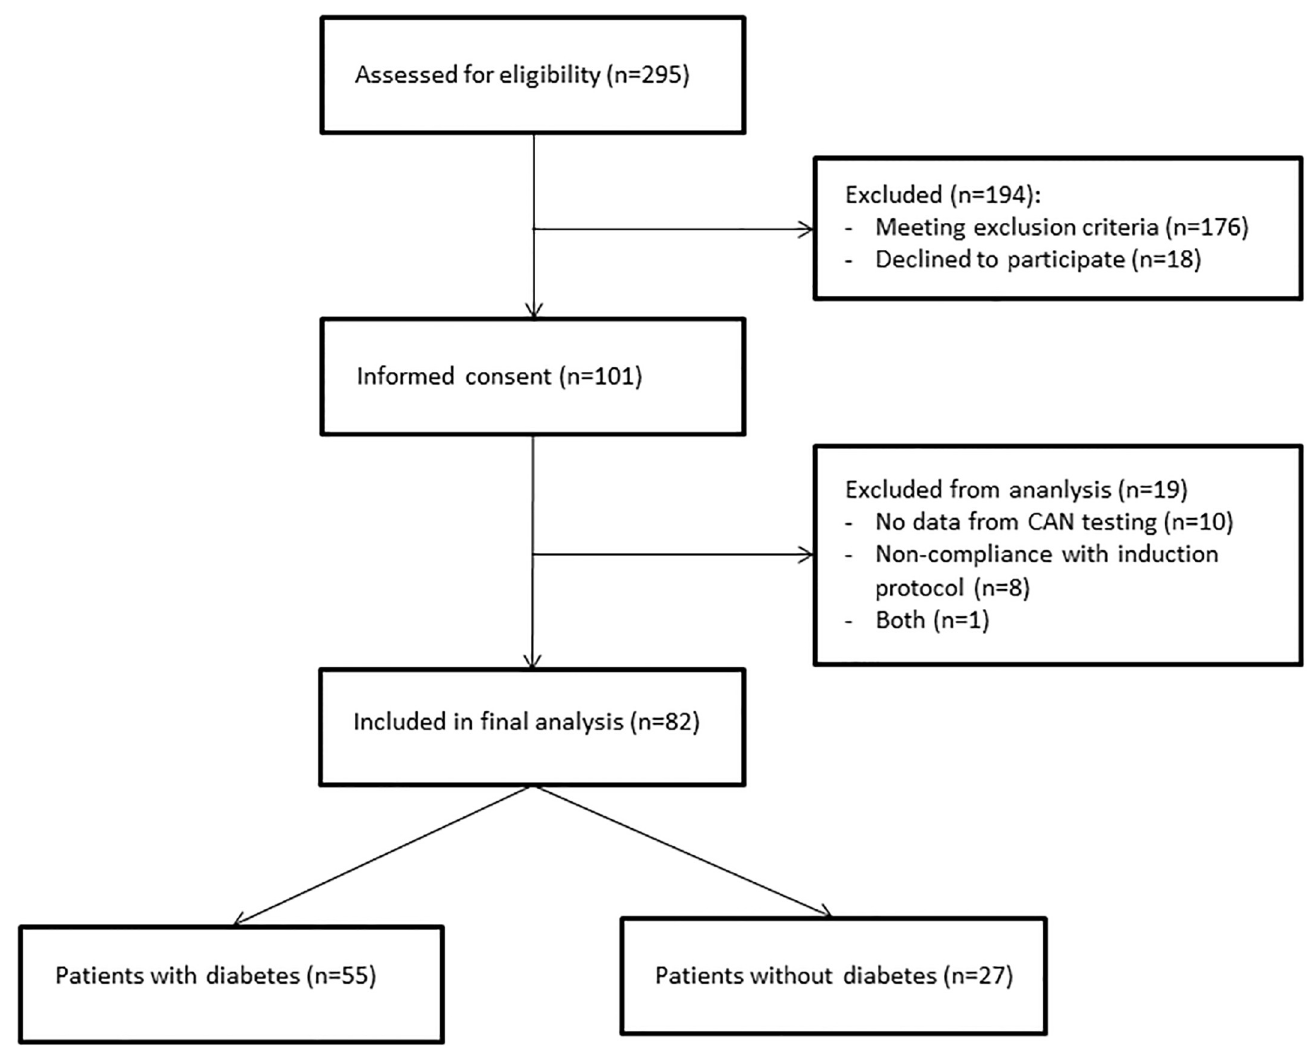
Fig 1. Flow chart of